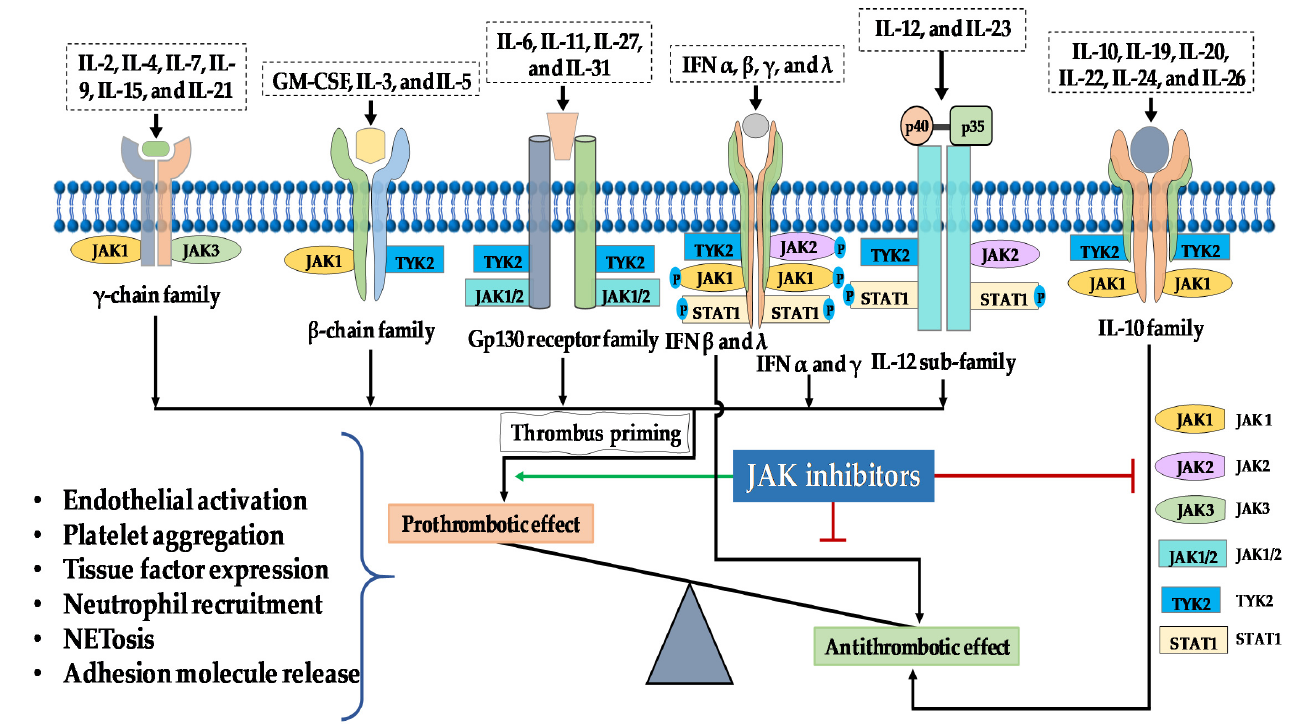
Figure 1. Possible mechanism for the prothrombotic effects associated with the administration of Jakinibs. JAKs in various combinations bind to cytokine receptors that transmit prothrombotic and proinflammatory signals from a wide range of cytokines. With the exception of IL-10, IFN β and IFN λ that exert anti-thrombotic potential, signaling downstream of these cytokines creates a permissive background for thrombus formation. Non-specific Jakinibs that target both of the IL-10R-associated JAKs (JAK1 and TYK2) or IFN β and IFN λ associated JAKs (JAK1 and TYK2) may result in an imbalance in the pro- and anti-thrombotic signaling resulting in thrombus priming.